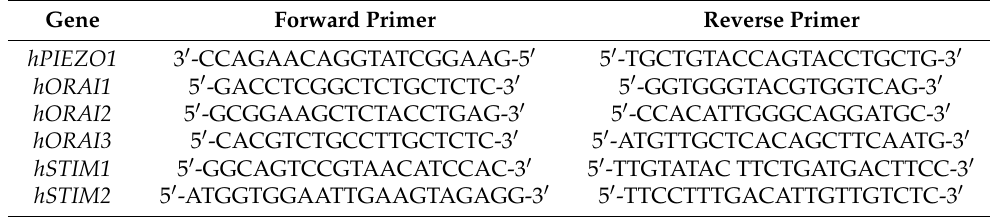
Table 1. Primers for RT-PCR